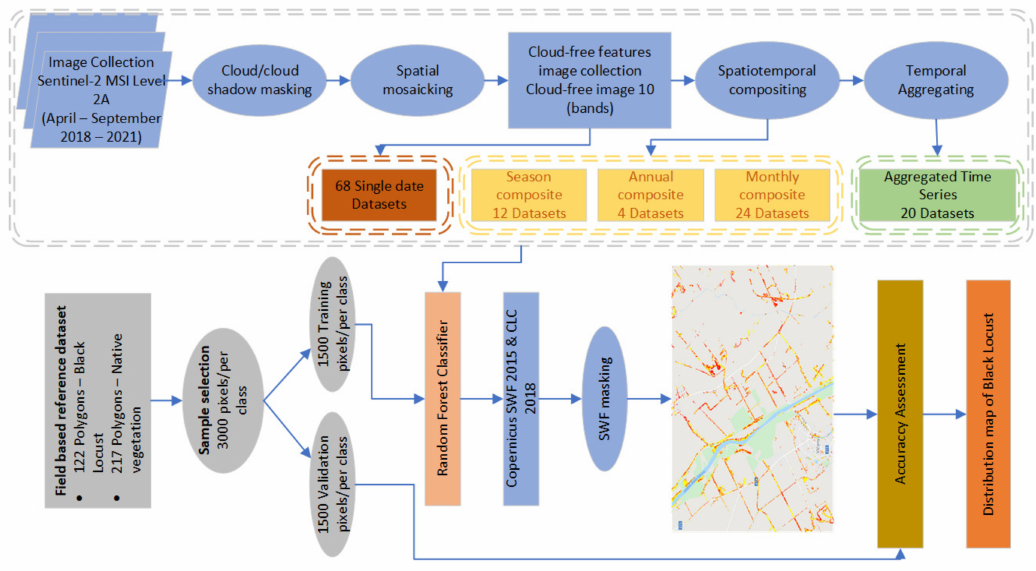
Figure 3. Workflow